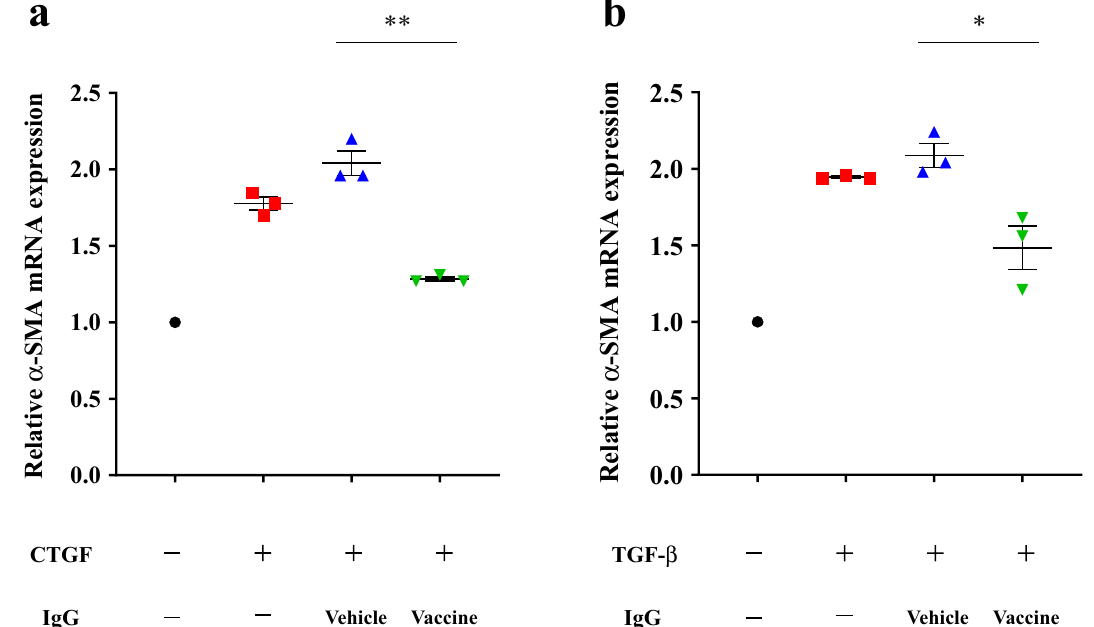
Figure 5. Effects of CTGF vaccine-elicited IgG antibodies on CTGF-induced or TGF-β-induced α-SMA expression in cultured kidney fibroblasts. IgG antibodies were purified from mice inoculated with the KLH vehicle or CTGF vaccine. After pretreatment with the IgG antibodies, NRK-49F kidney fibroblasts were stimulated with rhCTGF. ( a ) The data of relative α-SMA expressions normalized to β-actin expression were obtained by using real-time PCR. ( b ) The effect of IgG antibodies on TGF-β-induced α-SMA expression was examined in the same way. Error bars show mean ± SEM of three independent experiments. Statistical difference between the KLH vehicle and CTGF vaccine group was determined by using Student’s t -test. ** P < 0.01; * P < 0.05 as compared with IgG from mice treated with the CTGF vaccine-elicited IgG antibodies on recombinant human TGF-β-induced mRNA expression of CTGF and α-SMA were also examined in the same manner. In this experimental system, the administration of IgG from